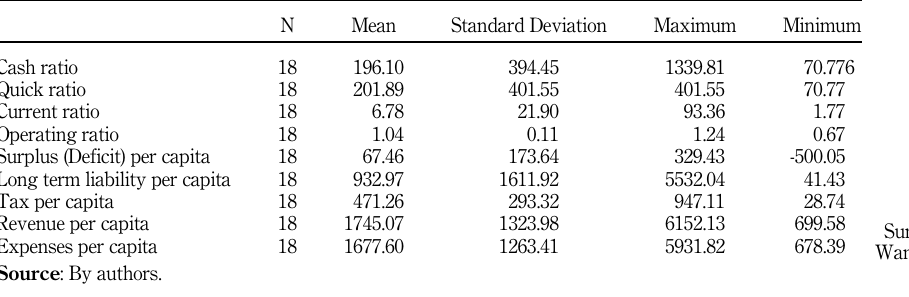
Table 3. Summary statistics